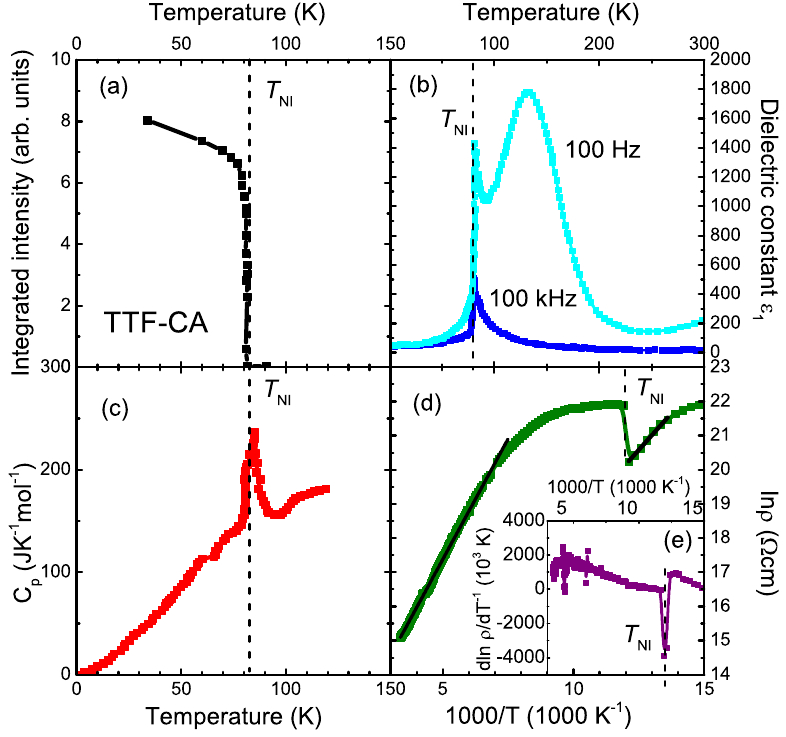
Figure 2. ( a ) Temperature-dependent (0 k 0)-reflection of TTF-CA [2], occurring after the loss of the twofold screw axis which is caused by the break of symmetry and the structural phase transition; ( b ) Temperature evolution of the real part (cid:101) 1 of the dielectric function, recorded at a frequency of 100 Hz (light blue) and 100 kHz (dark blue). (cid:101) 1 diverges for all frequencies at the critical temperature T NI and marks a first-order para- to ferroelectric transition [9]. The feature, appearing between T = 100 and 200 K for 100 Hz, is attributed to the excitation of neutral-ionic domain walls; ( c ) At the phase transition, the specific heat capacity C p of TTF-CA diverges similar to (cid:101) 1 , indicating a first-order phase transition [10]; ( d ) Arrhenius plot of the resistivity ρ dc (green) of TTF-CA along the stacking direction. Above the transition, it behaves as a classic band insulator with an activation energy of ∆ = 0.12